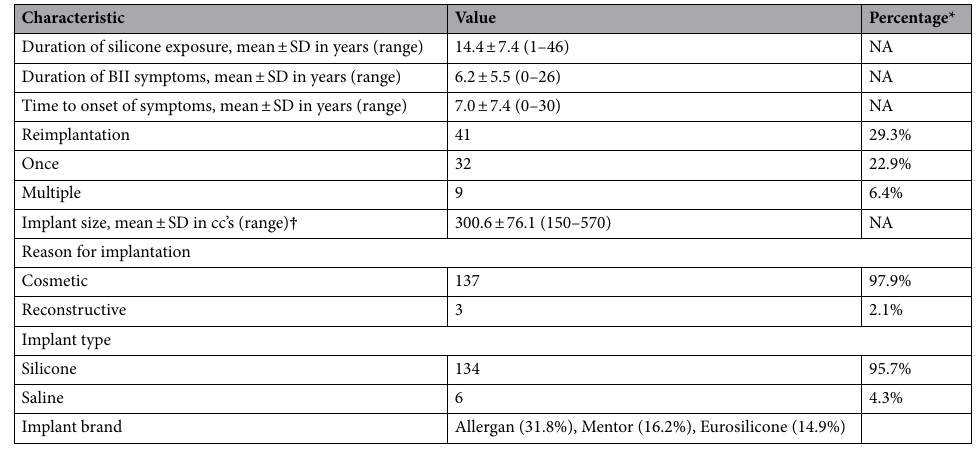
Table 3. Implant specific history (n = 140). *Percentage over total SBI population (n = 140). NA = Not applicable. † 12 missing values.